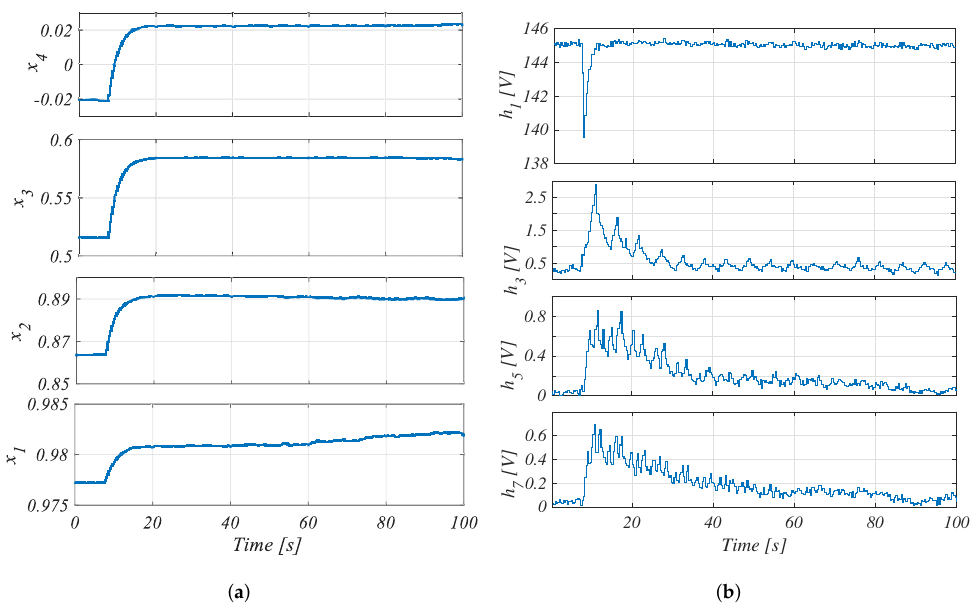
Figure 13. ( a ) Cosine of the switching-angles x k s in 200 W load insertion test, ( b ) Harmonics behavior of E 1 disturbance experimental